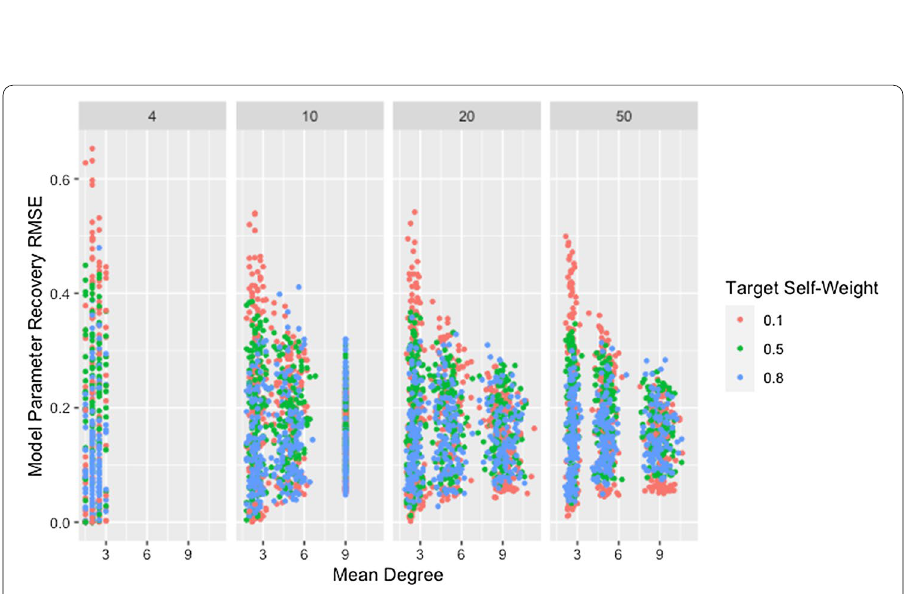
Fig. 6 RMSE for model parameter recovery by degree, self-weight, and size. RMSE for known and predicted weights by mean degree, target self-weight, and network size across